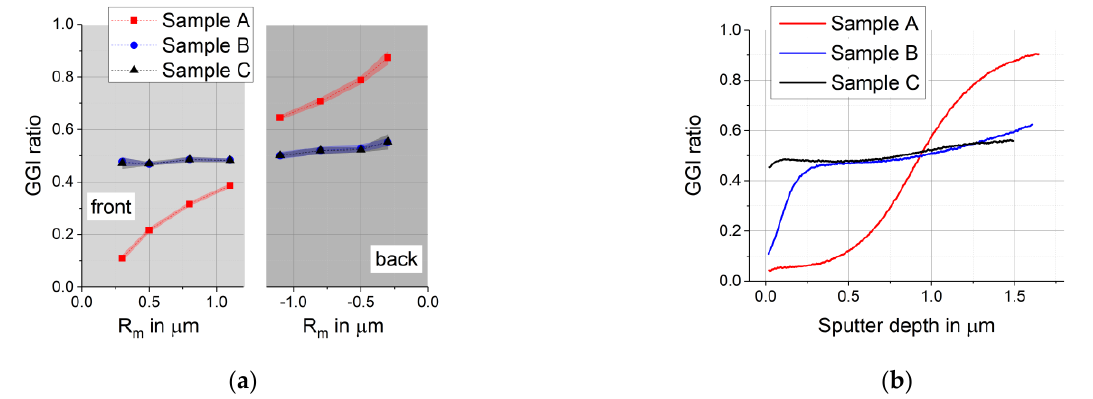
Figure 8. [Ga]/([Ga]+[In]) ratio (GGI ratio) calculated from: ( a ) EDX measurements with different acceleration energies at the front and back of the delaminated absorber; ( b ) GDOES measurements.